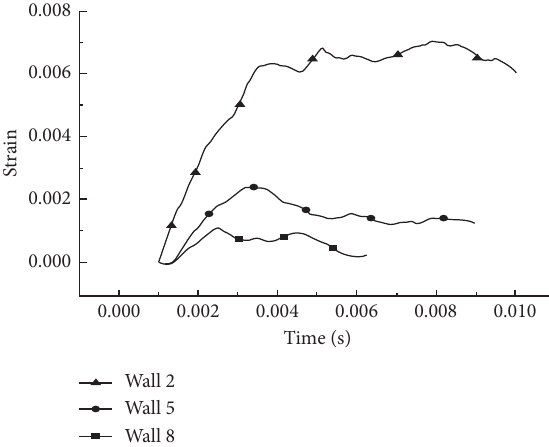
Figure 14: Comparison of strain–time curves of Walls 2, 5, and 8.